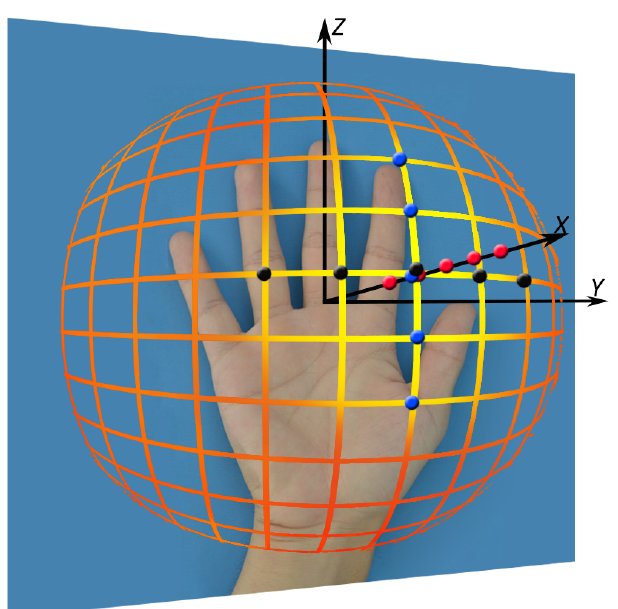
Figure 15. The simulation of viewpoint variation. The yellow region indicates the range that our method can tolerate. The images captured at the red, black and blue points are shown in the second to fourth row in Figure 14